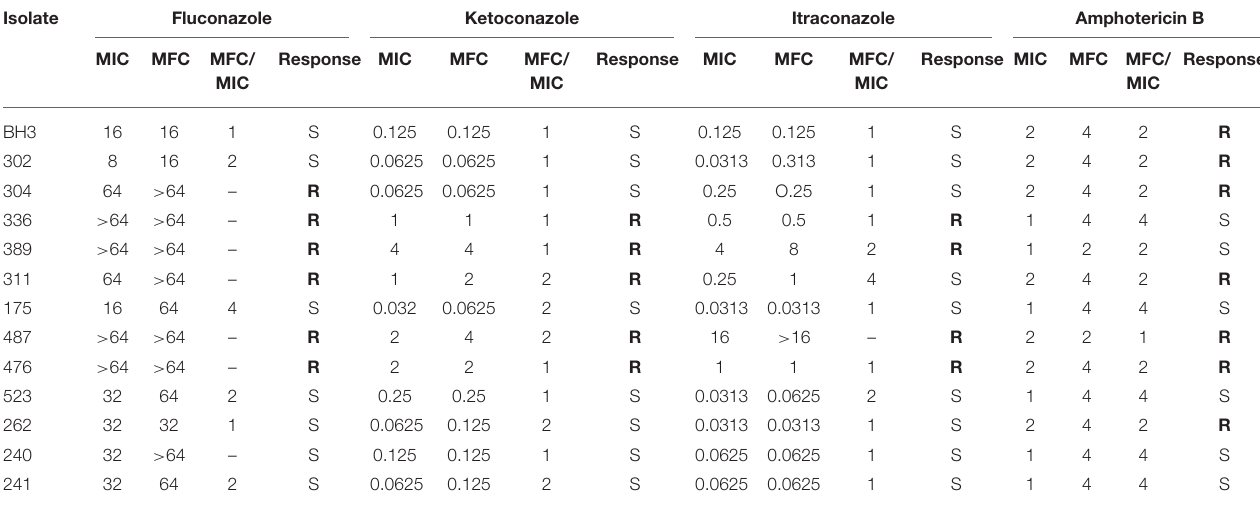
TABLE 1 | The MIC and MFC ( µ g/mL) values and MFC/CIM ratio of commercial antifungals used against Malassezia pachydermatis isolates, obtained via broth microdilution. Isolate Fluconazole Ketoconazole